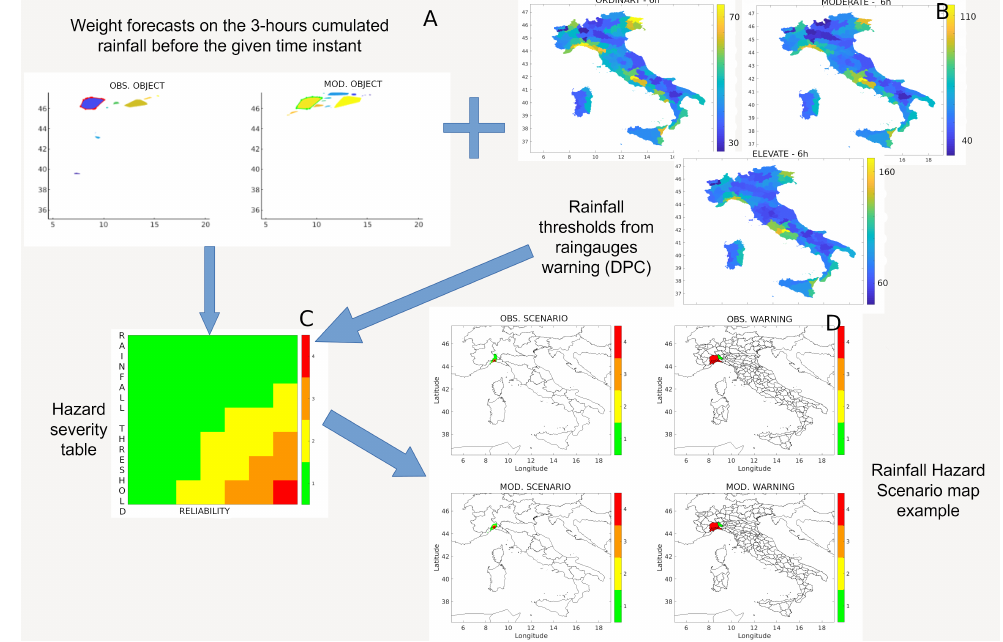
Figure 6. SWING hazard scenarios generation. Starting from the forecasts weightings with respect to observations (Panel ( A )) and the rainfall thresholds from the Italian Civil Protection Department warning system (Panel ( B )), the hazard level for each rainfall object is retrieved from the hazard severity table (Panel ( C )). Eventually, the hazard scenario maps and the warning on the alert areas are obtained (Panel ( D